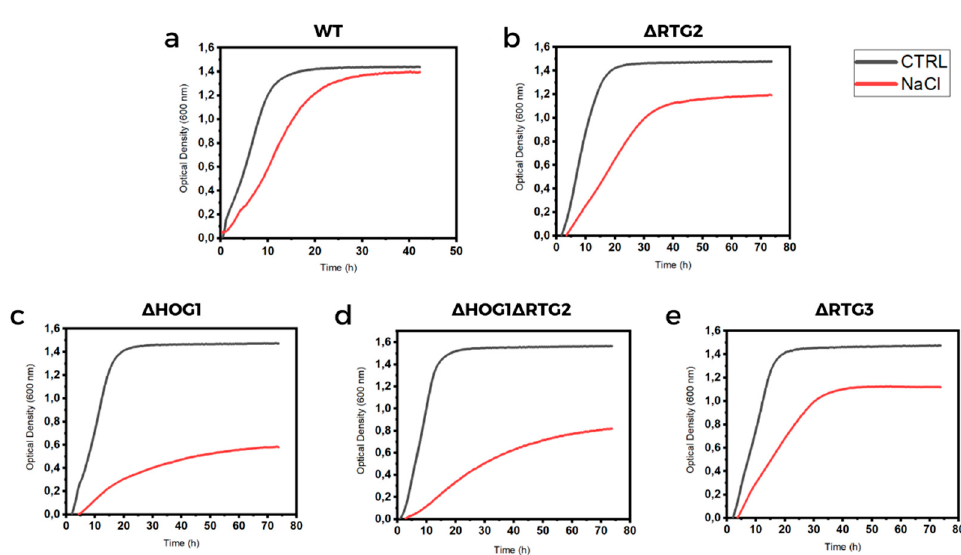
Figure 2. Sensitivity of wild type and mutant cells to sodium chloride. Wild-type (WT) and mutant cells, lacking RTG2 ( ∆ RTG2), RTG3 ( ∆ RTG3) and/or HOG1 ( ∆ HOG1; ∆ HOG1 ∆ RTG2) , were grown overnight in YPD medium and diluted to 1 OD 600 , and ten-fold serial dilutions were spotted on YPD plates without (CTRL) or with 0.8 M sodium chloride (NaCl). Growth was scored after 2–5 days.